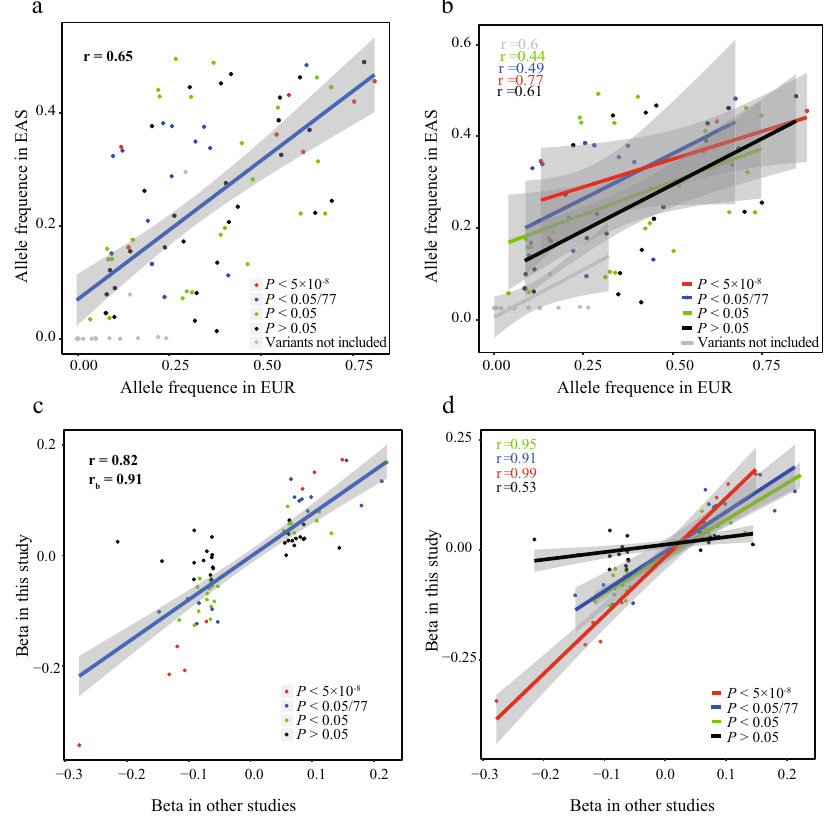
Fig. 5 Correlation plots. a , b Allele frequency — Allele frequency plot showing the correlation of minor allele frequencies for reported genome-wide signi fi cant variants between European ( x -axis) and East Asian populations ( y -axis); allele frequencies were extracted from gnomAD database. c , d Beta-beta plot showing the correlation between effect sizes derived from the GWAS in which they were reported ( x -axis) and effect sizes calculated in this study ( y -axis); beta in other studies were from European population (Nalls, 2019) and East Asian population (Foo, 2020). Red dots denote variants with P < 5 × 10 − 8 , blue dots denote variants with P < 0.05/77, green dots denote variants with P < 0.05, black dots denote variants with P > 0.05, and grey dots denote variants not included in replication cohort of this study. r shows the Pearson correlation coef fi cient and r b shows the correlation coef fi cient correcting for errors in the estimated effects. EUR European, EAS East